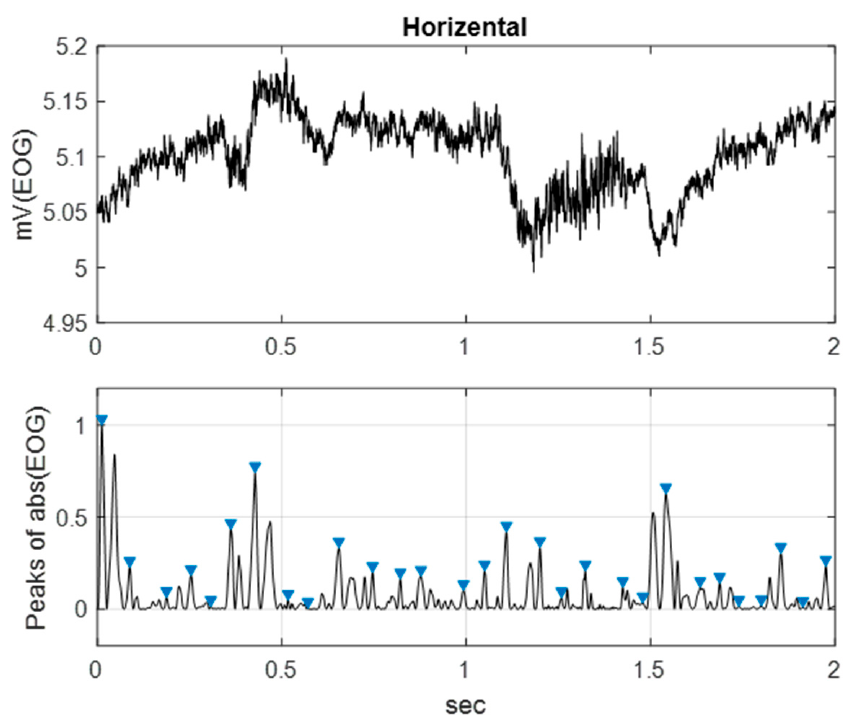
Figure 8. The EOG pattern of “horizontal” eye movement from one channel EOG system with the electrospun electrodes assembled on a headset. (y-axis unit: a normalized value of millivolt).